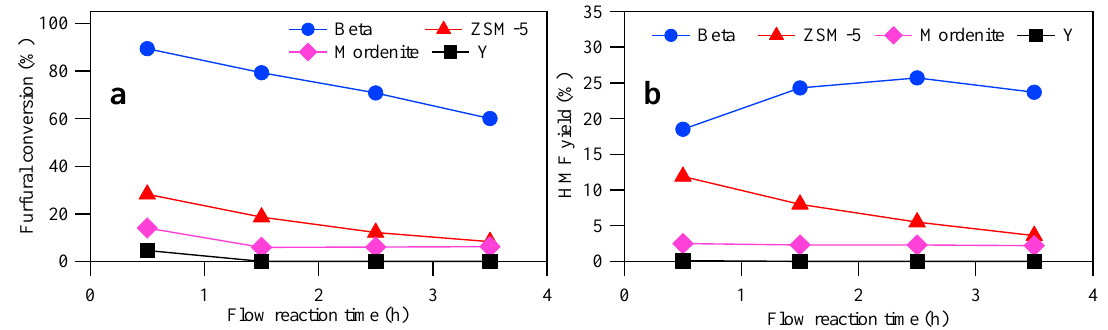
Figure 4. Time-based reaction for HMF production in a flow reactor using four different types of zeolites. Reaction conditions: furfural (10 mmol), formalin (50 mL), catalyst (500 mg), temperature (363 K), flow rate (0.2 mL min −1 ).